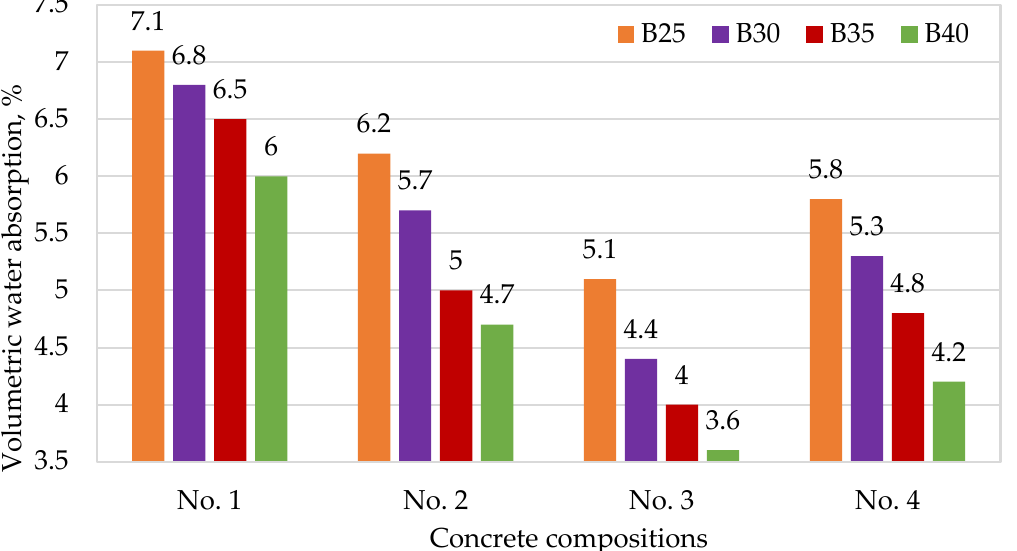
Figure 6. Dependence of volumetric water absorption of concrete on the application of modifiers and volumetric fiber reinforcement: No. 1—no additives; No. 2—with CCM; No. 3—with CCM and HPC; No. 4—with CCM, HPC, and fiber.